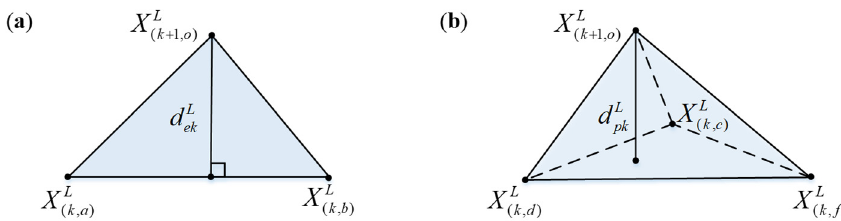
Figure 4. Schematic diagram of LiDAR residual construction. ( a ) Line characteristic residual con- struction; ( b ) surface characteristic residual construction.